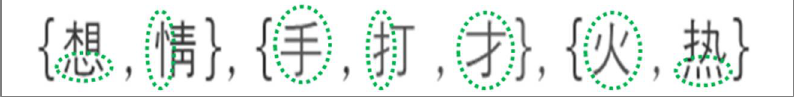
Figure 6. Examples of different shapes of the same components.